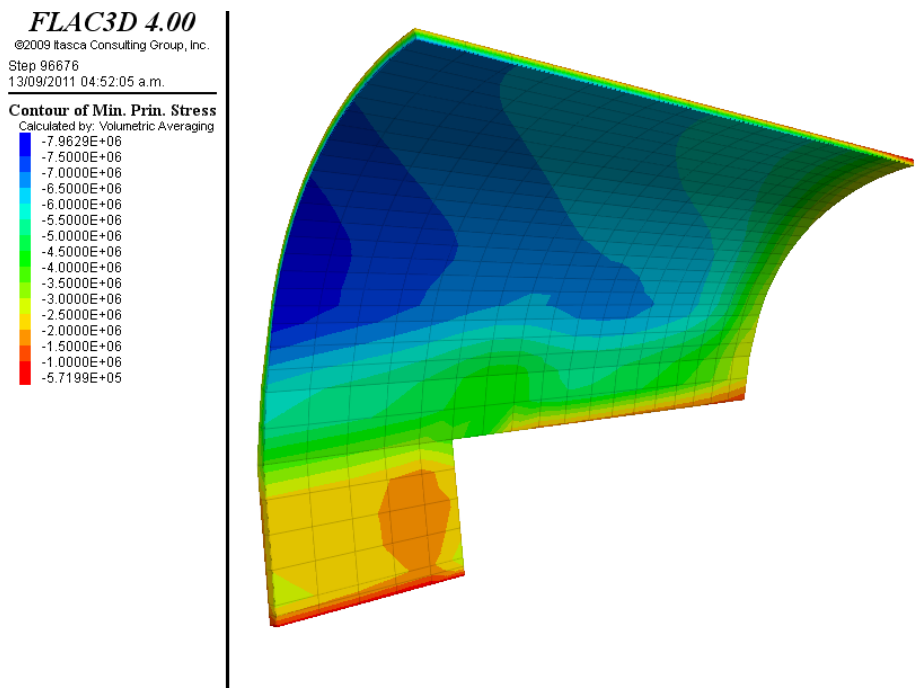
Figure 34. Contours of major principal stress σ 1 (in N/m 2 ) in concrete elements. Minimum parame- ters.